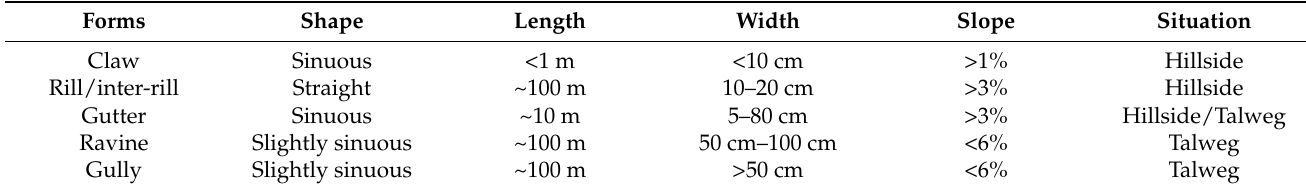
Table 6. Distinctions between soil erosion forms as a function of their size